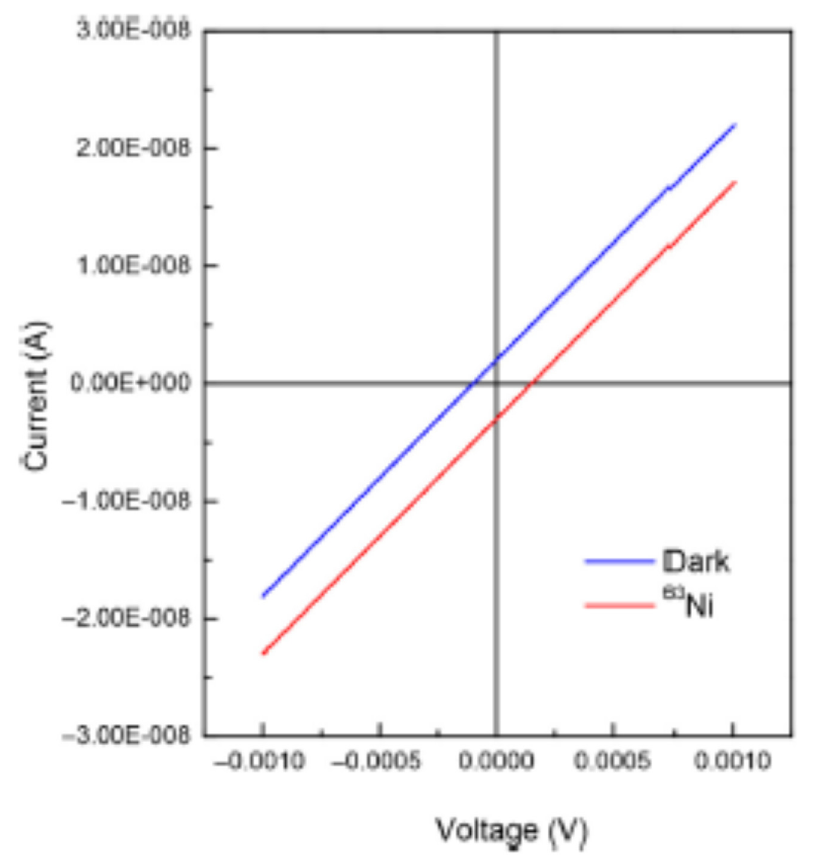
Figure 7. Planar battery performance characteristic of magnified I ‐ V curves. Reproduced with permission from [124].